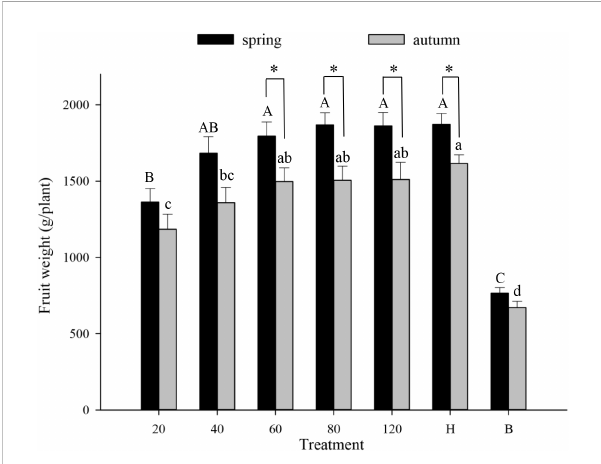
(Figure 4A). Similar results were obtained during autumn, with the extent of aphid population reduction directly proportional to hover fl y release rate (Figure 4B). However, the degree of population reduction was smaller than during spring, especially at low hover fl y release rates. On day #31, aphid population levels were reduced by 53.5 ± 12.9%, 66.5 ± 12.2%, 80.4 ± 10.2%, 95.0 ± 5.6% and 97.8 ± 3.8% as compared to the hormone group (Figure 4B).